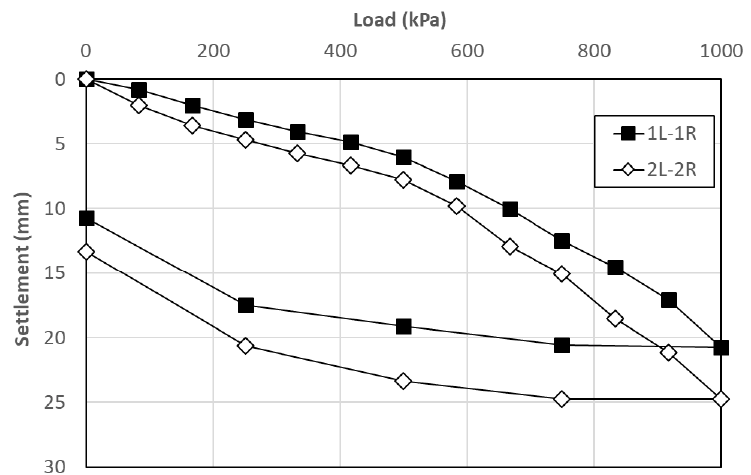
Figure 12. Load-settlement curve of static loading test.